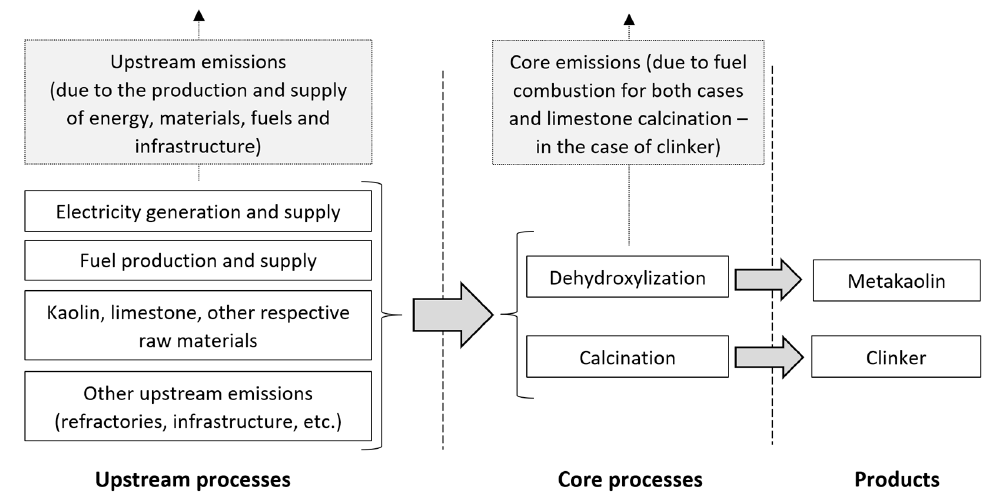
Figure 3. System boundaries and input/output flows considered.